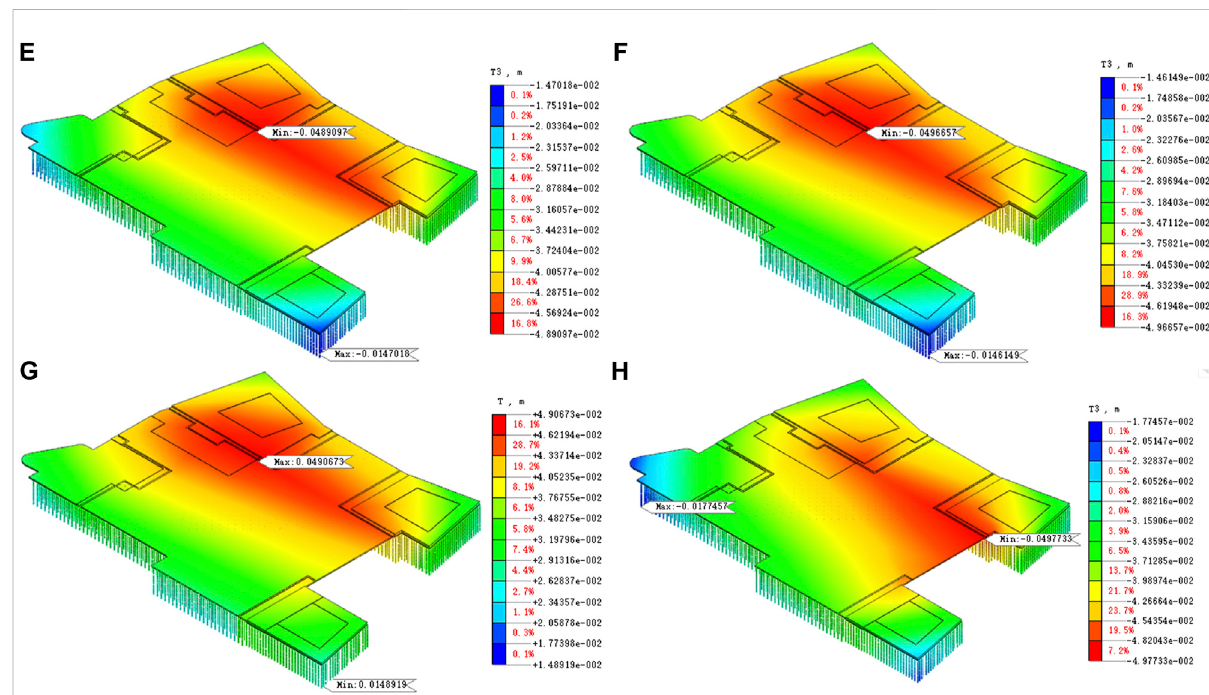
FIGURE 6 (continued). Overall settlement contour diagram of the scheme combinations. (A) Scheme combination 1 (B) Scheme combination 2. (C) Scheme combination 3 (D) Scheme combination 4. (E) Scheme combination 5 (F) Scheme combination 6. (G) Scheme combination 7 (H) Scheme combination